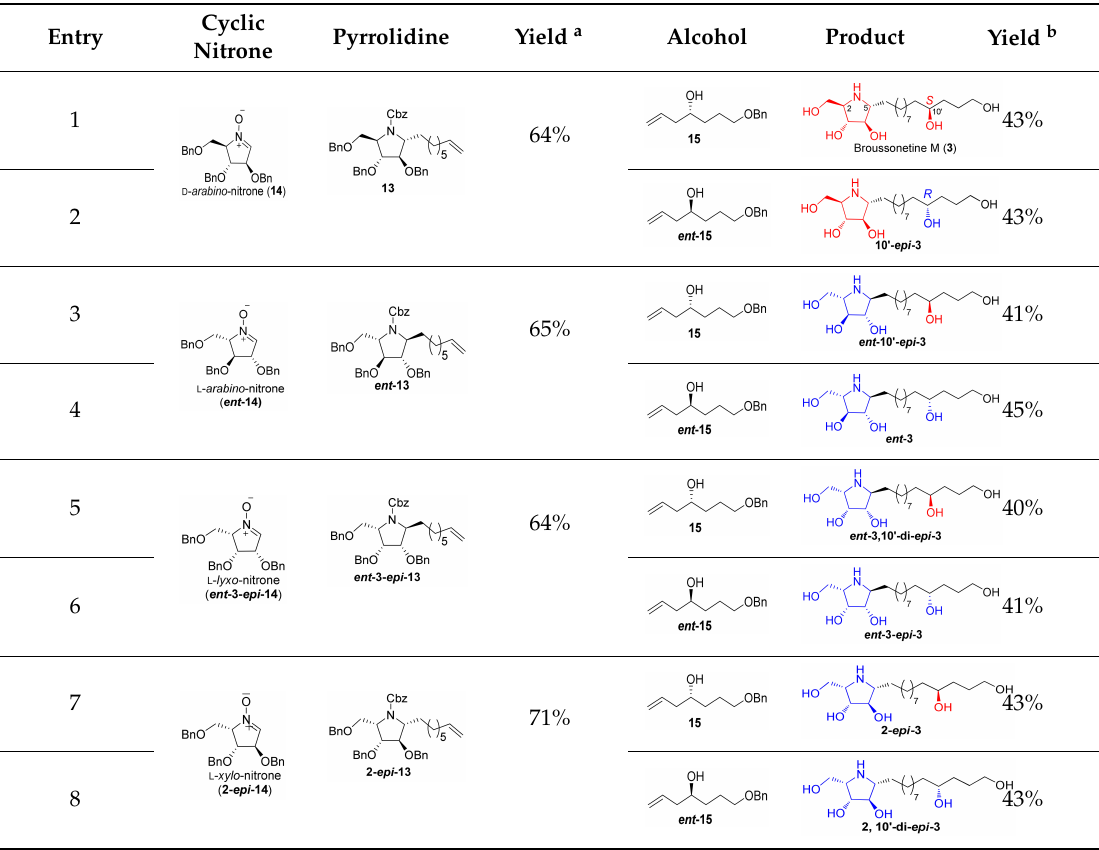
Table 1. Broussonetine M ( 3 ) and analogues synthesized from di ff erent cyclic nitrones and